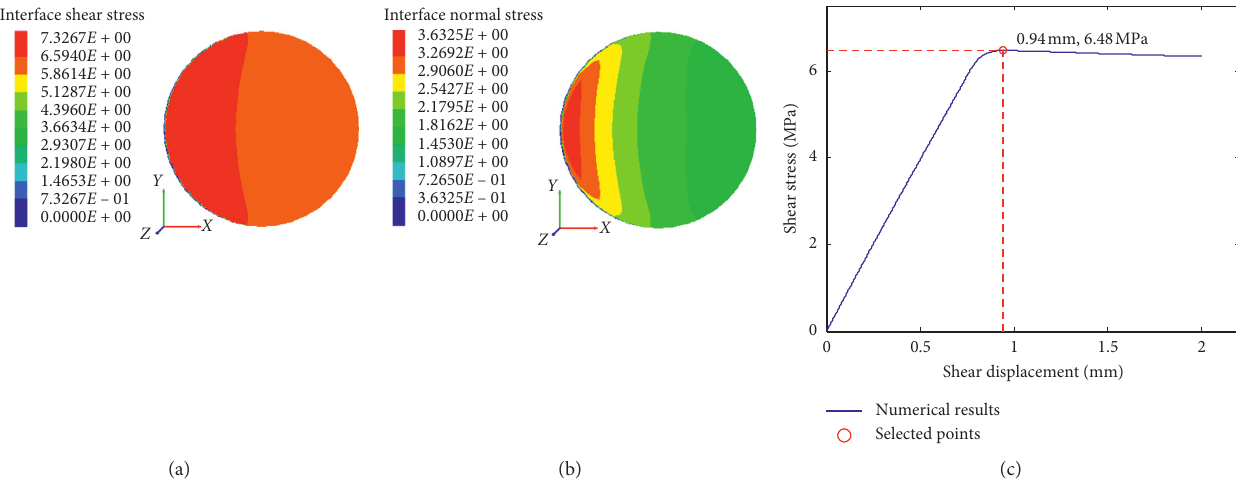
Figure 14: Distribution of the shear stress and normal stress on the shear failure plane when the shear displacement arrived at 0.94mm: (a) shear stress distribution; (b) normal stress distribution; (c) point selected on shear stress-shear displacement